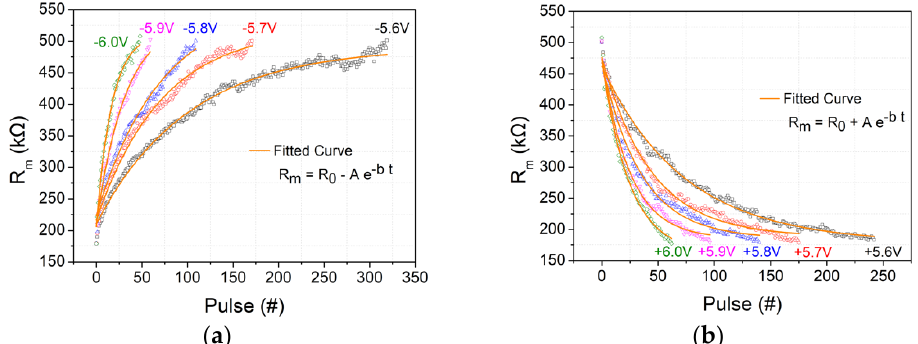
Figure 4. Single exponential experimental fitting on ( a ) depression and ( b ) potentiation measured data for ± 5.6 V to ± 5.9 V/1 μ s pulses.